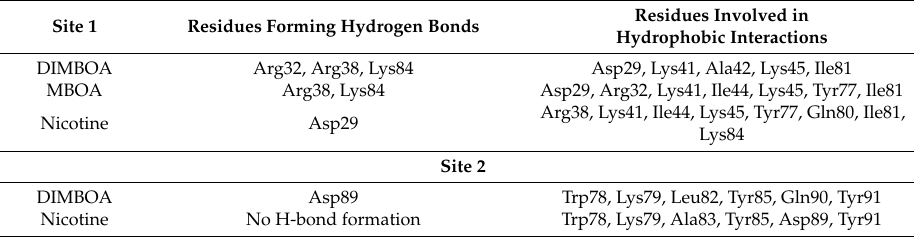
Figure 4. Cartoon representation of the interaction of: ( A ) DIMBOA, ( B ) Nicotine, and ( C ) MBOA at site 1, and ( D ) DIMBOA and ( E ) Nicotine at site 2 of SlitCSP3. Table 1. SlitCSP3 residues from site 1 and site 2 showing interactions with secondary metabolites.